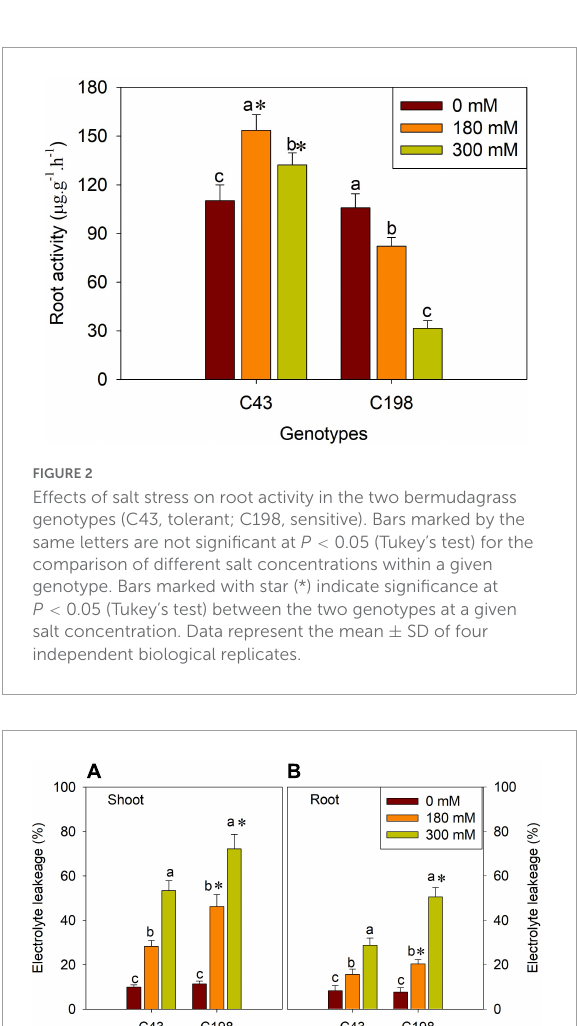
FIGURE3 Effects of salt stress on shoot (A) and root (B) membrane stability in the two bermudagrass genotypes (C43, tolerant; C198, sensitive). Bars marked by the same letters are not significant at P < 0.05 (Tukey’s test) for the comparison of different salt concentrations within a given genotype. Bars marked with star (*) indicate significance at P < 0.05 (Tukey’s test) between two genotypes at a given salt concentration. Data represent the mean ± SD of four independent biological replicates.